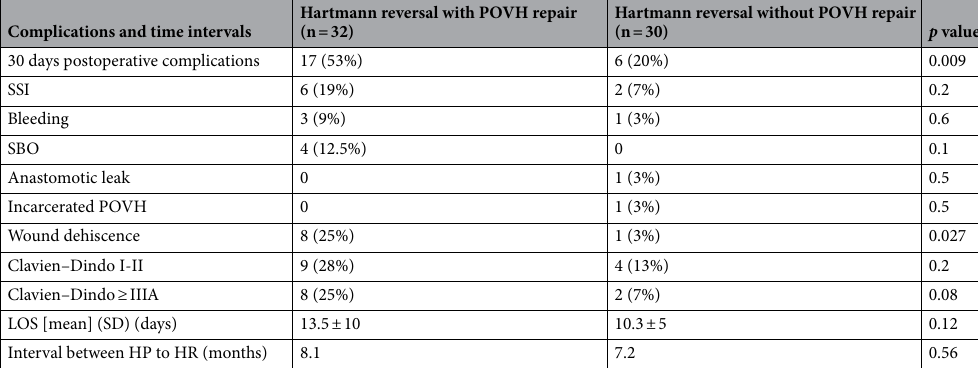
Table 3. Description of perioperative outcome—patients with POVH following HP, which underwent Hartmann reversal with POVH repair compared to patients that underwent Hartmann reversal alone. POVH post operative ventral hernia, SSI surgical site infection, SBO small bowel obstruction, Clavien–Dindo the Clavien–Dindo classification of surgical complications, LOS Length of stay, HP Hartmann’s Procedure, HR Hartmann reversal.